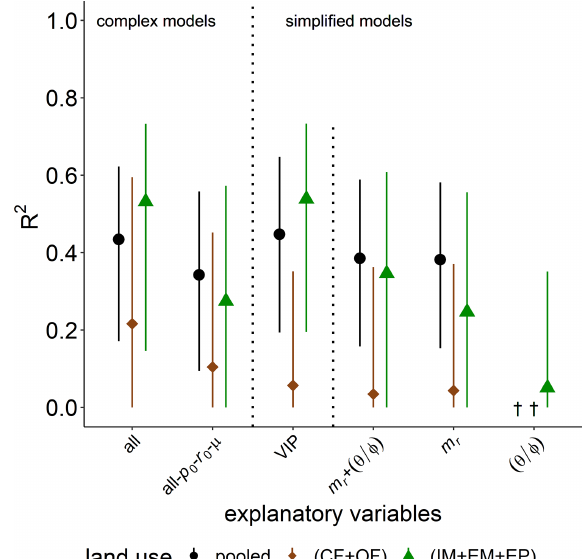
Figure 6. Explained variability ( R 2 ) of basal respiration, p b , by different combinations of explanatory variables for all land uses (pooled) or only cropland (CF + OF) and grassland (IM + EM + EP), respectively. The all- p o - r o - µ model includes all explanatory variables except for microbial variables. The VIP model include the variables of importance in predicting p b (please see the text for more information). † No variability explained.